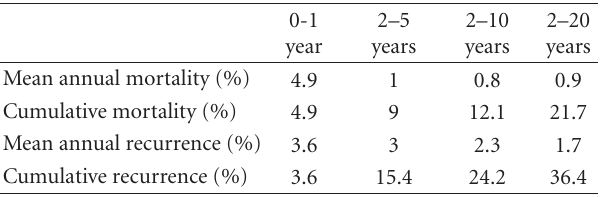
Table 2: Annual and cumulative rates of mortality and recurrent stroke in young adults after a first-ever ischemic stroke, based on data of study of Varona et al. [12].